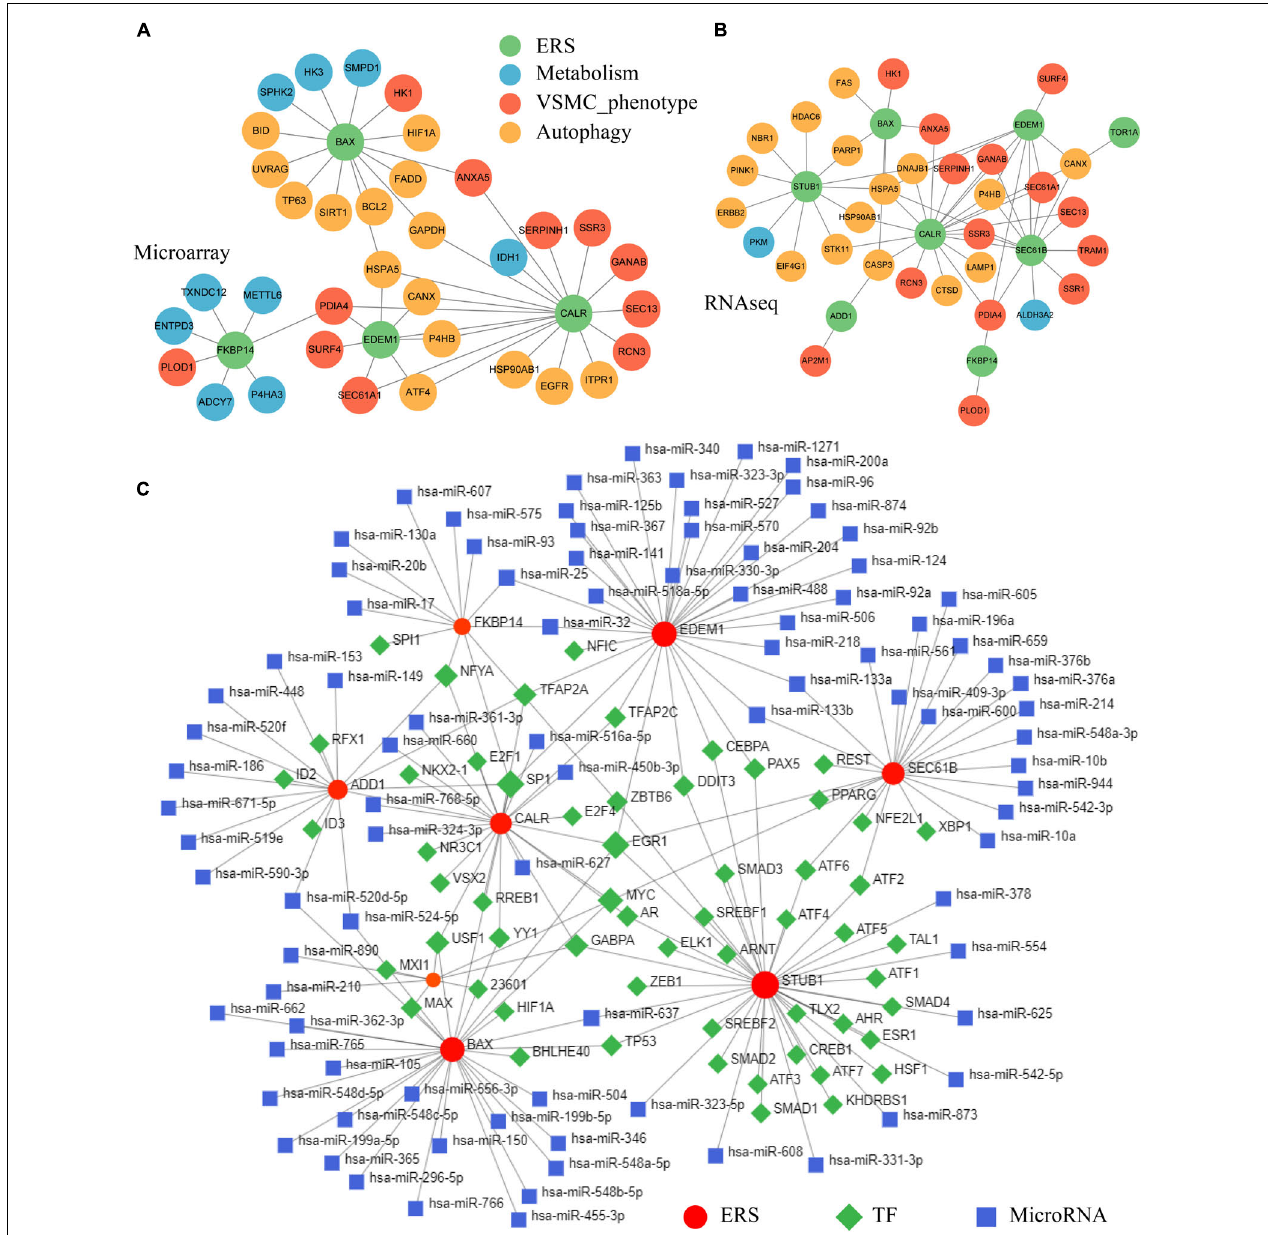
FIGURE 8 | Constructing ERS-VSMC-metabolism-autophagy PPI and ERS-TF-miRNA networks. (A) PPI network among ERS, metabolism, VSMC phenotype, and autophagy-related genes in the training cohorts. (B) PPI network among ERS, metabolism, VSMC phenotype, and autophagy-related genes in the validating cohorts. (C) Prediction of upstream TFs and microRNAs for ERS-related genes.